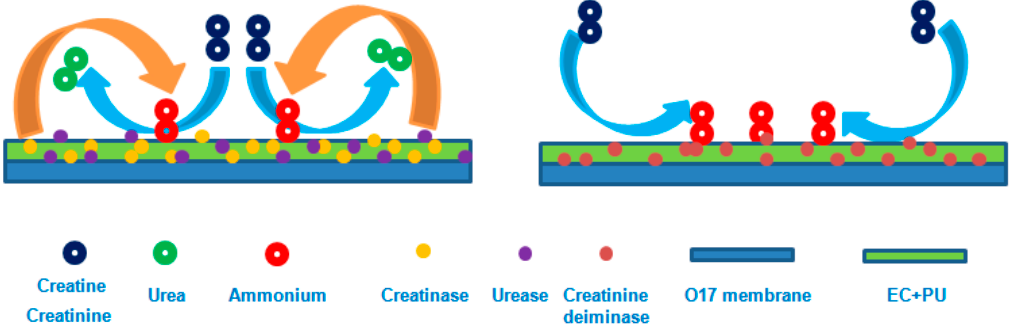
Scheme 1. Structure of the creatine sensor ( left ) and creatinine sensor ( right